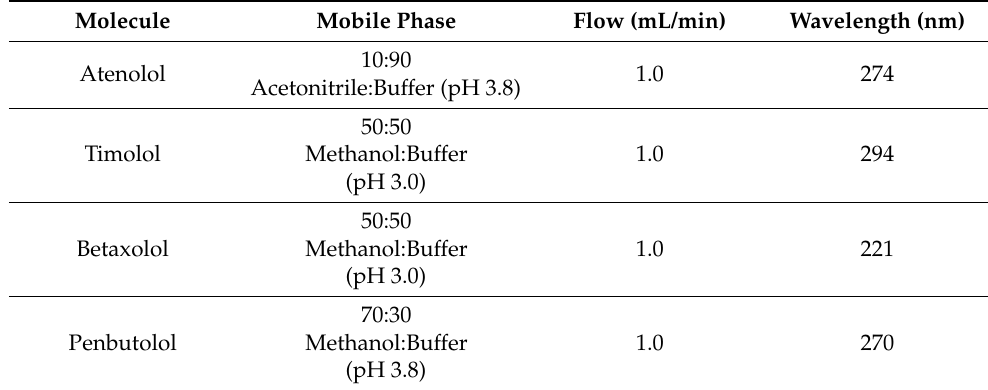
1.0 274 1.0 294 1.0 221 1.0 270